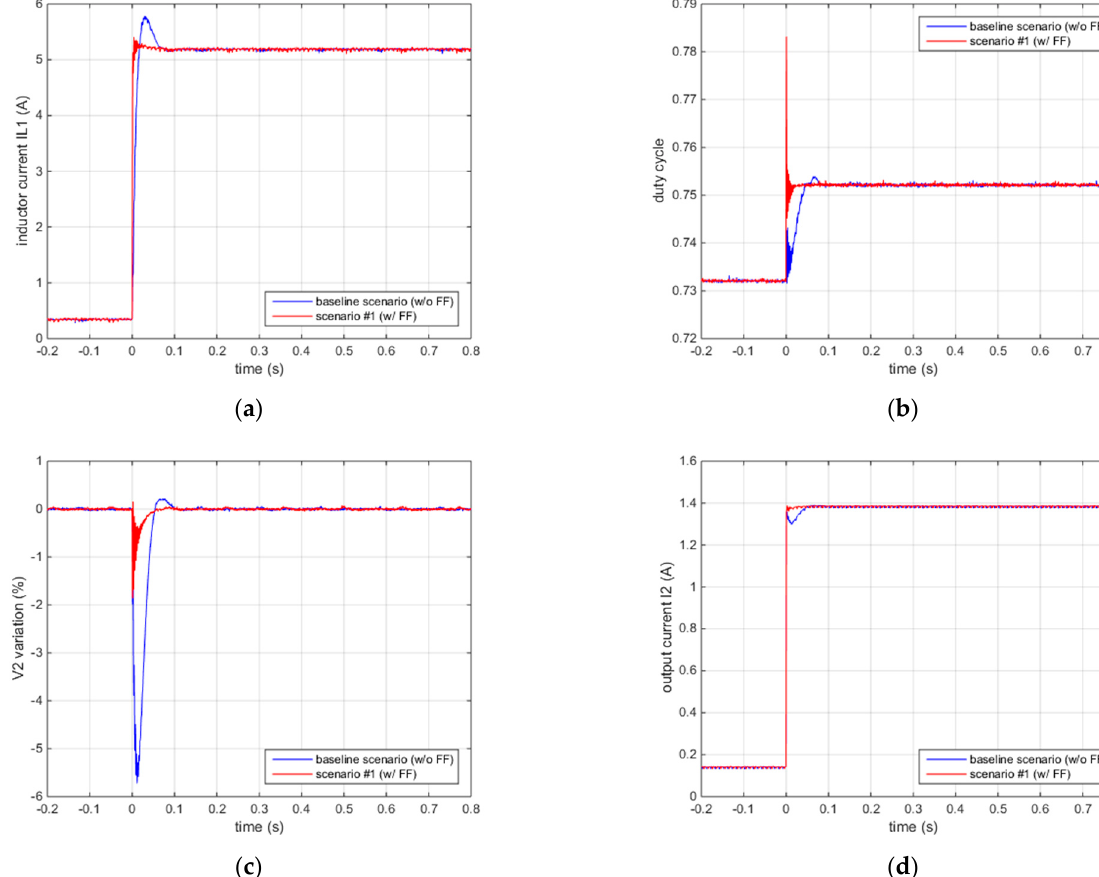
Figure 10. Experimental results in the baseline scenario and scenario #1 (SS − GN): ( a ) input inductor current; ( b ) duty cycle; ( c ) percentage variation of microgrid voltage; ( d ) grid − side current.